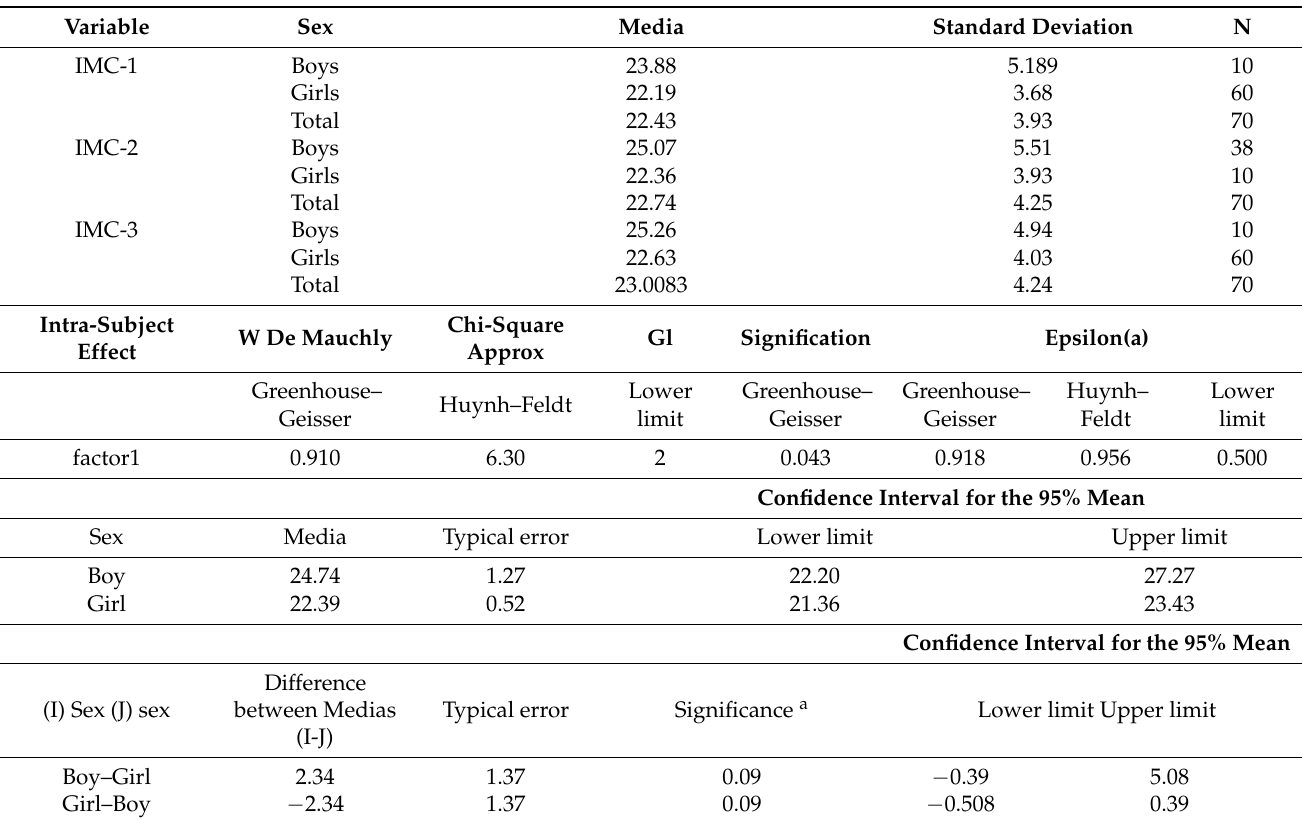
Table 3. The ANOVA test with repeated measures was used, for the three measures of BMI and for the sex; Descriptive statistics; Mauchly sphericity test; estimated marginal means; Peer comparison.